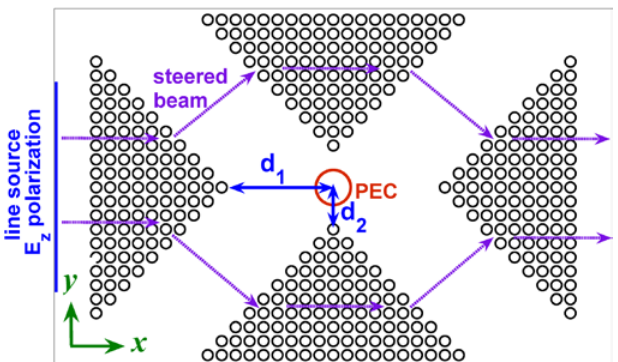
Figure 3: Di rectional c loak ba sed on t he be am s teering effect at higher photonic bands. d 1 and d 2